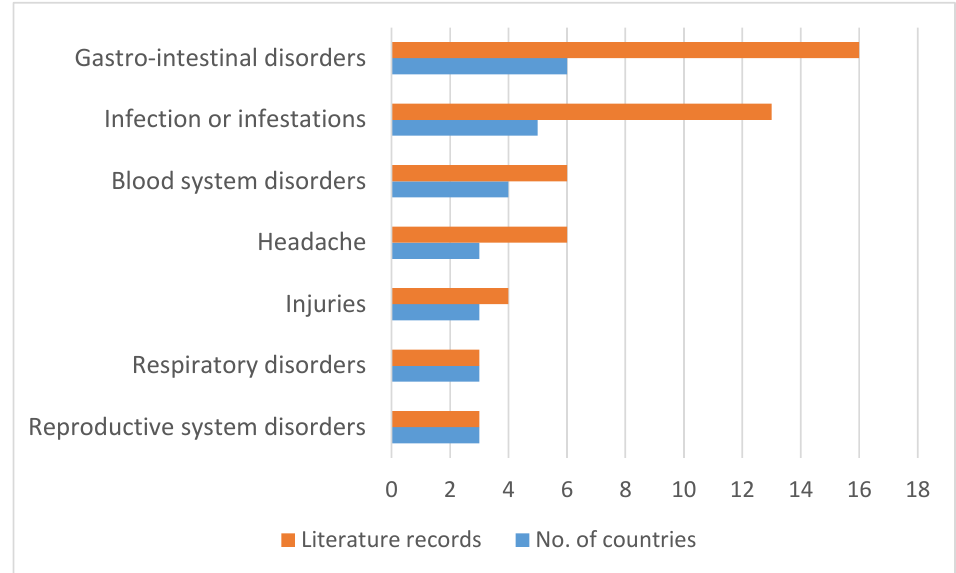
Figure 3. Different plant parts of Lannea schweinfurthii used as herbal medicines in south, central and east Africa.